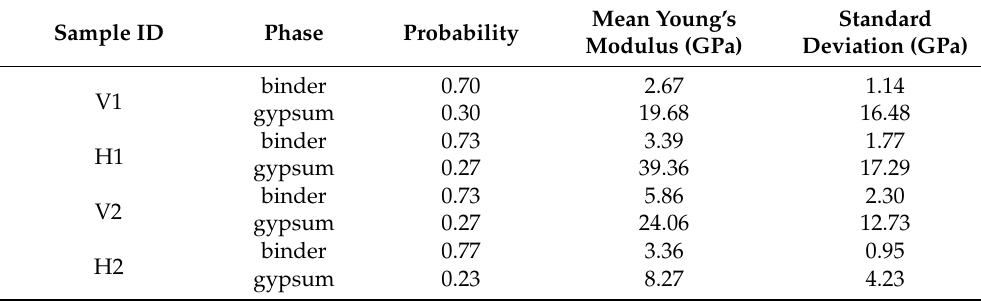
Table 1. Deconvolution results of Young’s modulus of four samples.